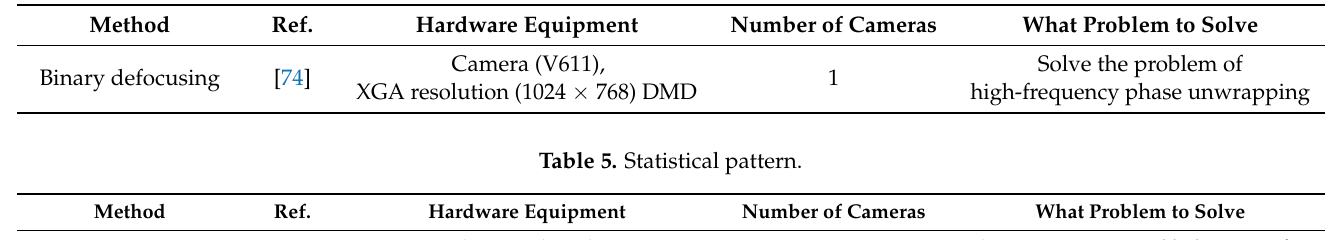
Table 4. Binary defocusing.